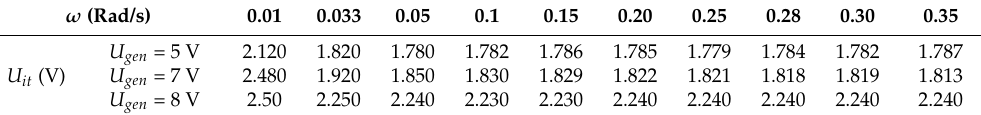
Table 2. Dependence of the IT output voltage on the vibration table oscillation frequency at different excitation voltages.